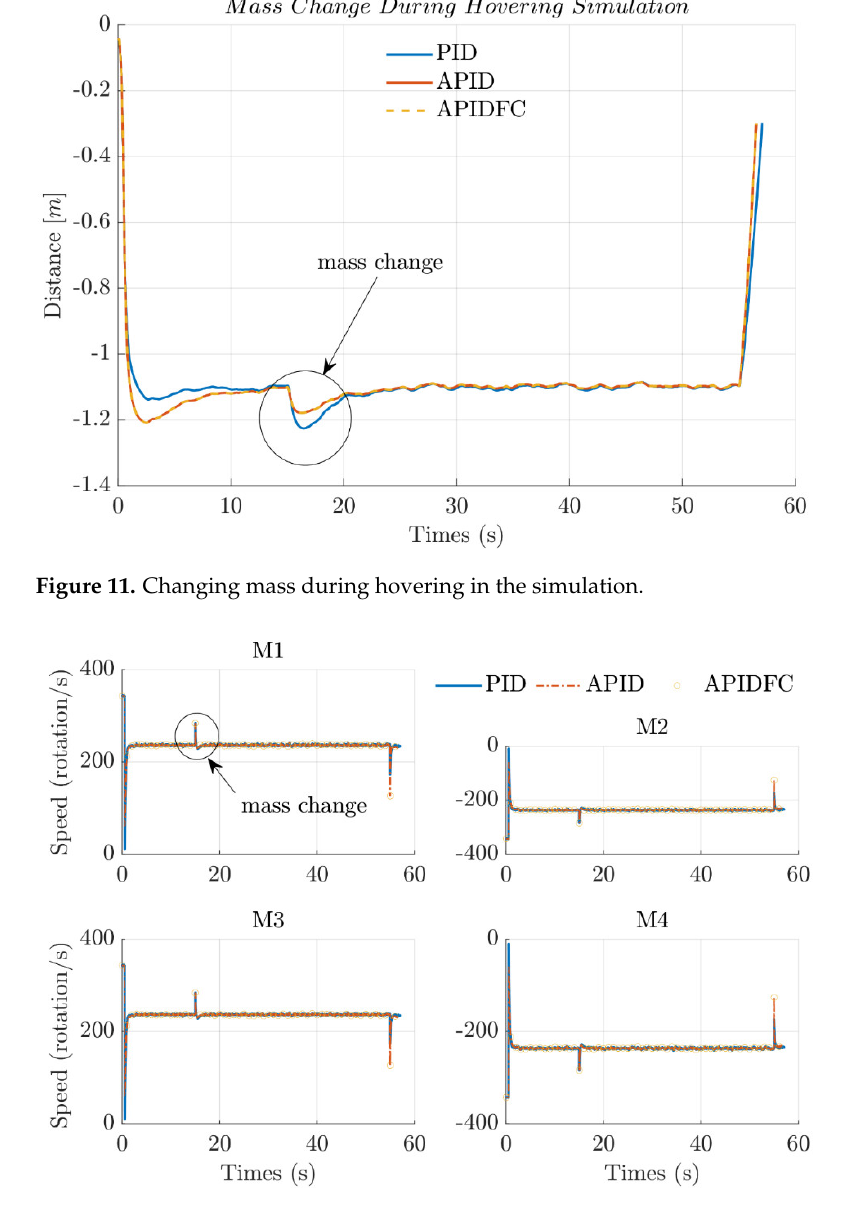
Figure 12. Motor speed rotation for mass change during hovering in the simulation.